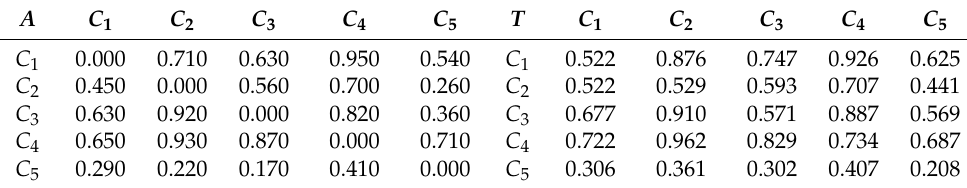
Table 5. The direct and total influence relations matrix of D 1- motivation.